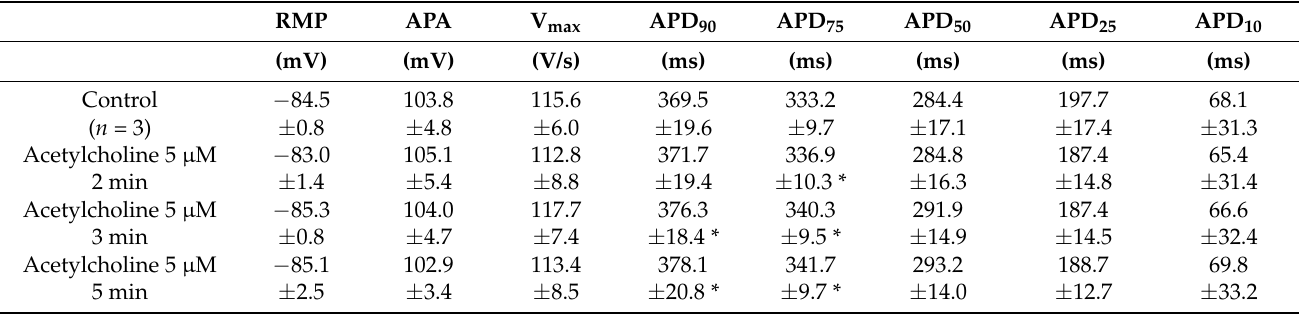
Table 1. Effects of ACh on human myocardial slice action potential parameters at pacing cycle length of 1000